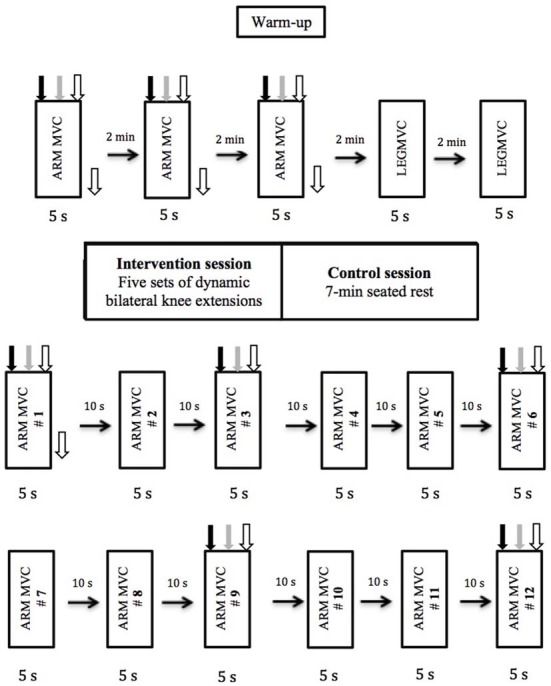
Experimental design and procedures. The order in which the different types of stimulations were delivered is depicted and was kept constant for all subjects and for both sessions. Black arrow pointing down represents transcranial magnetic stimulation (TMS), gray arrow represents transmastoid electric stimulation, white arrow represent brachial plexus electrical stimulation (BPES) and black arrow pointing to the right represents rest period.